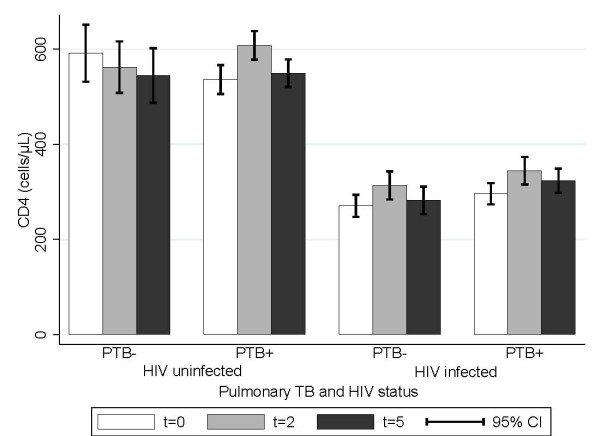
CD4 levels at different time points during TB treatment. PTB +/-; pulmonary TB case microscopy or culture positive/negative. Time is indicated in months: e.g. t = 2; sample drawn after 2 months of terapy.